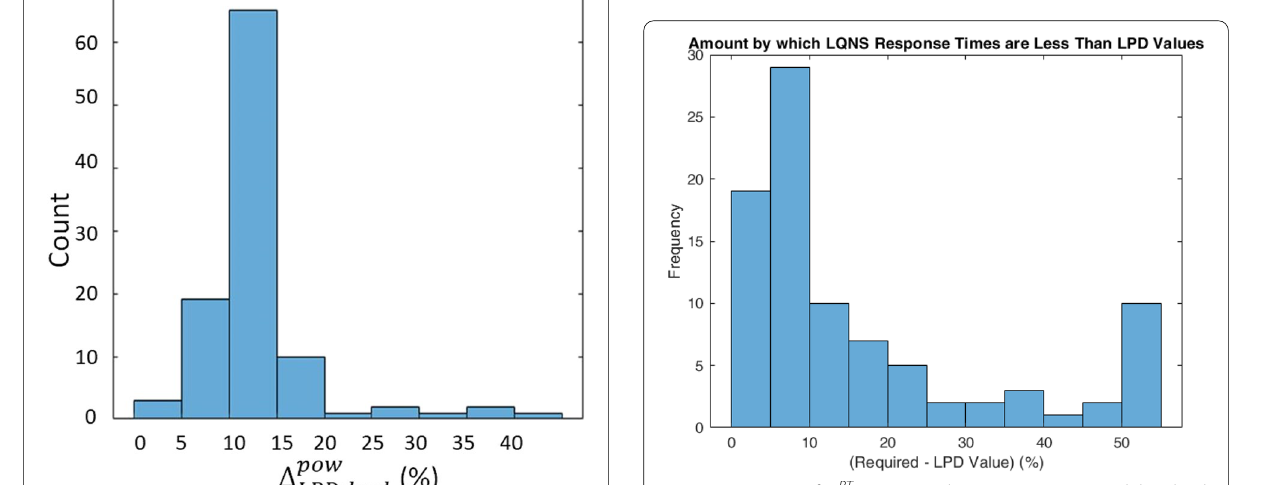
Fig. 8 Histogram of (cid:31) RT LPD : LQNS . It is always positive (90 models solved by